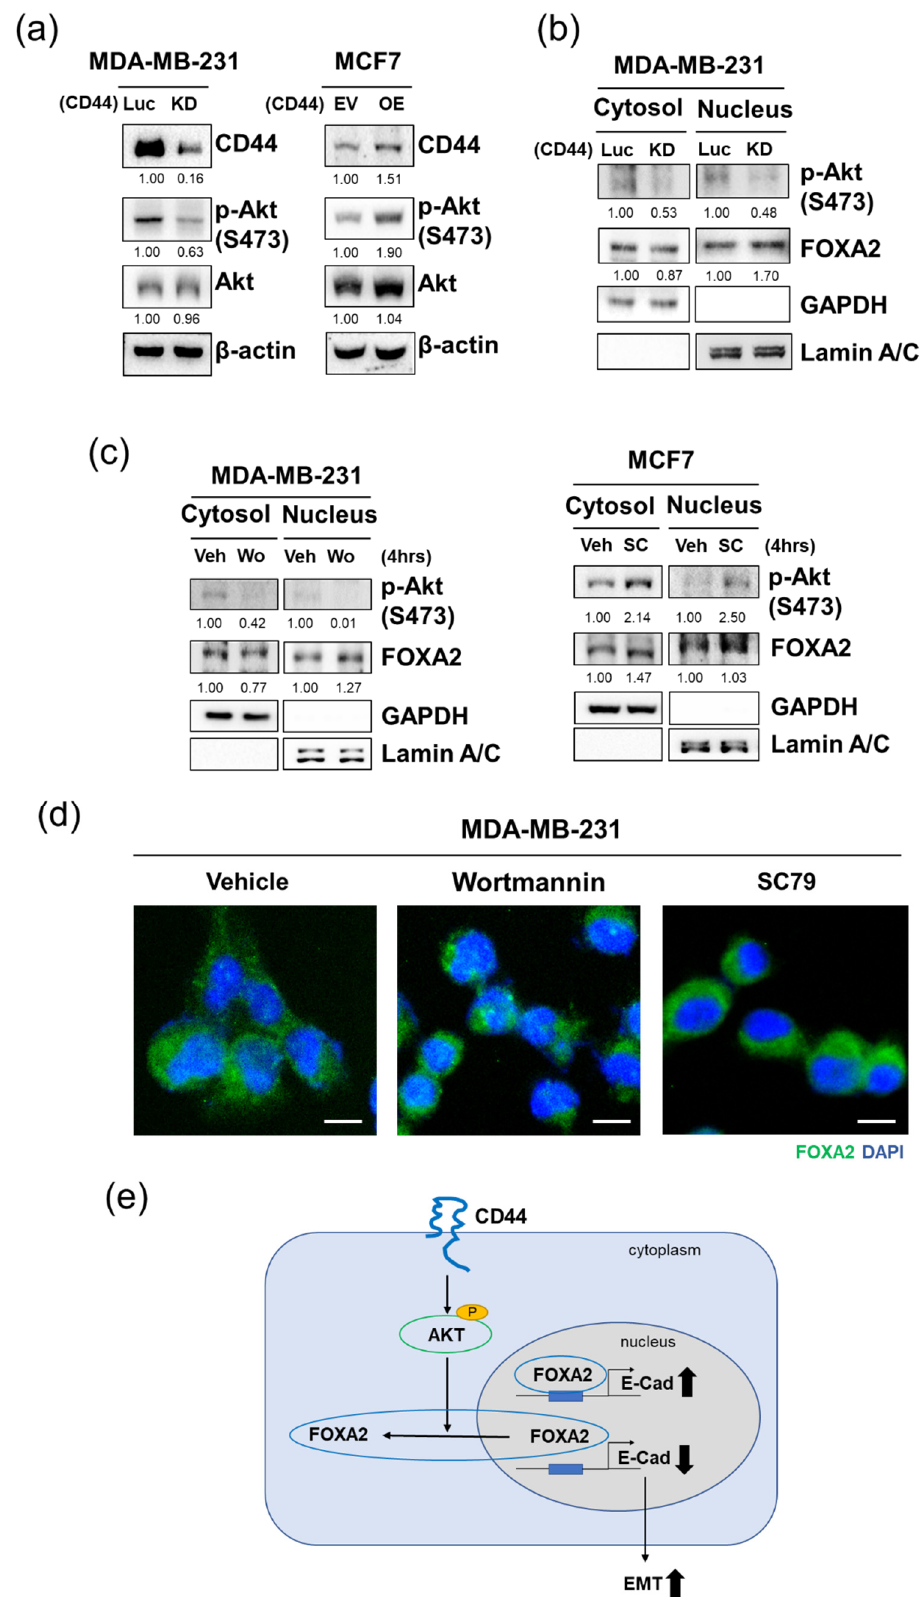
Figure 6. AKT activation results in the cytoplasmic translocation of FOXA2: ( a ) Immunoblotting for AKT and p-AKT protein expression in CD44 knockdown and overexpressed MDA-MB-231 and MCF7 cells, respectively. ( b ) Immunoblotting for the cytoplasmic and nuclear expression of p-AKT and FOXA2 in CD44 knockdown MDA-MB-231 cells. ( c ) Immunoblotting for the cytoplasmic and